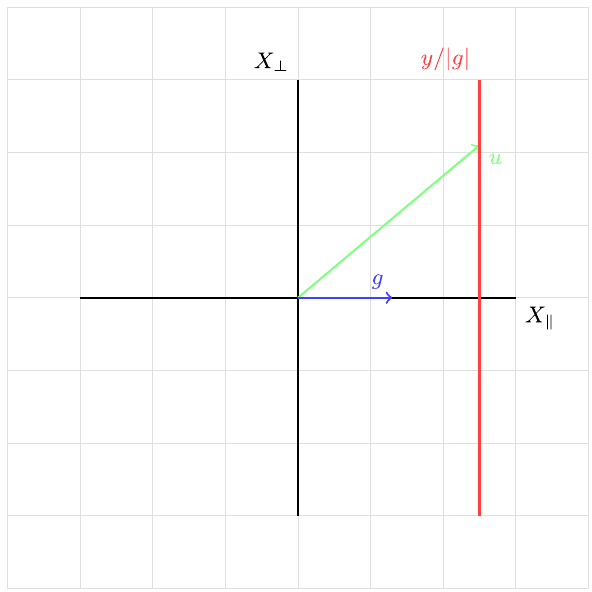
Fig. 1 A linear model in a two-dimensional space is constrained by a single data point y . Once the vector g is given, the model is fully specified by the vector u , viz. y = g T u . All models u along the vertical red line reproduce exactly the data point. In the absence of prior knowl- edge, every model along that one-dimensional subspace is a legitimate solution of the inverse problem, which is clearly